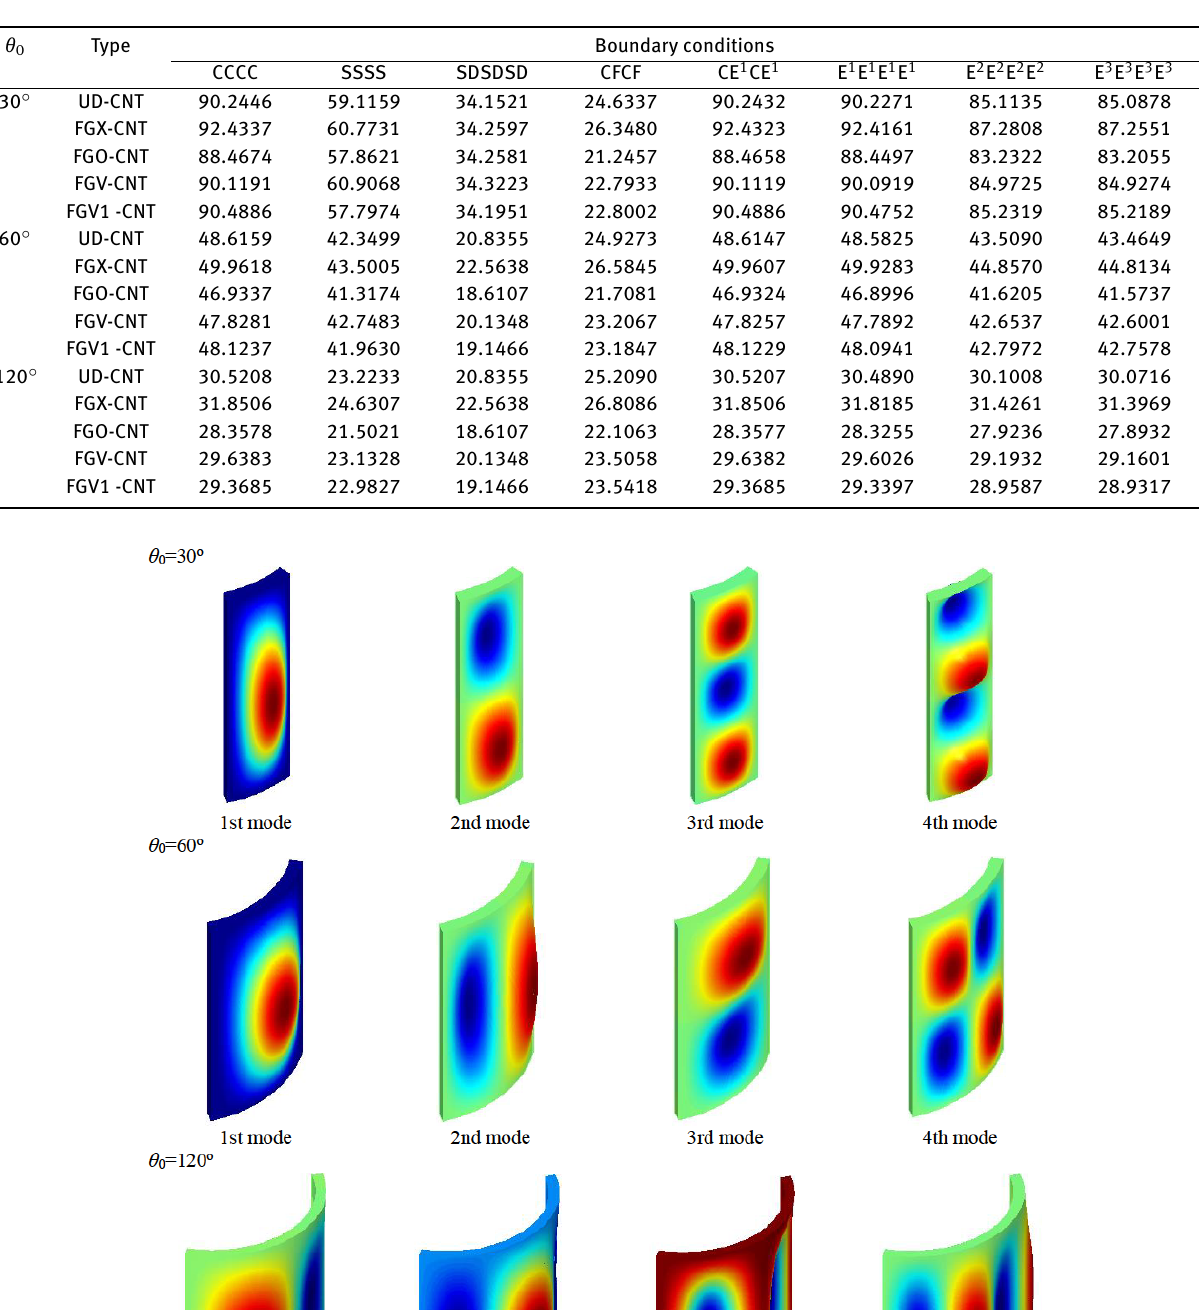
Table 6: Fundamental frequency parameters Ω for FG-CNT reinforced composite panels with various boundary conditions and CNT volume fractions V tcnt =0.12.